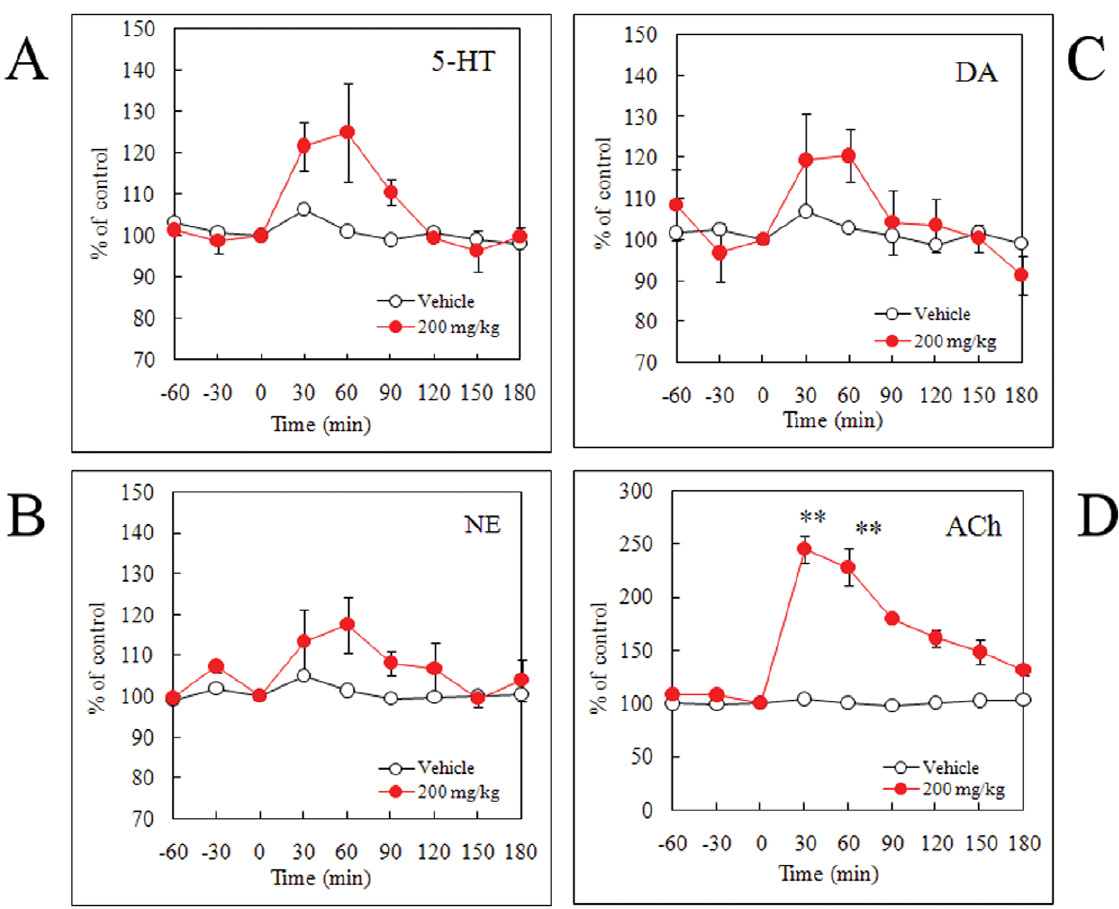
Figure 3. Effects of single administration of cyclo( L -Phe- L -Phe) on extracellular levels of serotonin (5-HT) (A), norepinephrine (NE) (B), and dopamine (DA) (C) in the medial prefrontal cortex (mPFC) and extracellular levels of acetylcholine (ACh) (D) in the ventral hippocampus (VHIPP) of freely moving rats measured using brain microdialysis. Male Sprague–Dawley rats were orally administered 200 mg/kg cyclo( L -Phe- L -Phe). Values within the treated groups were compared to those of the vehicle group at respective time points (two-way analysis of variance followed by Bonferroni’s post-test; ** P , 0.01. All values are mean 6 standard error, n=6 rats).